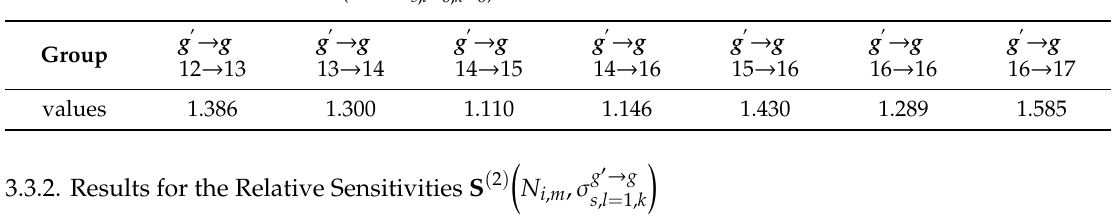
Table 14. Elements of S ( 2 )